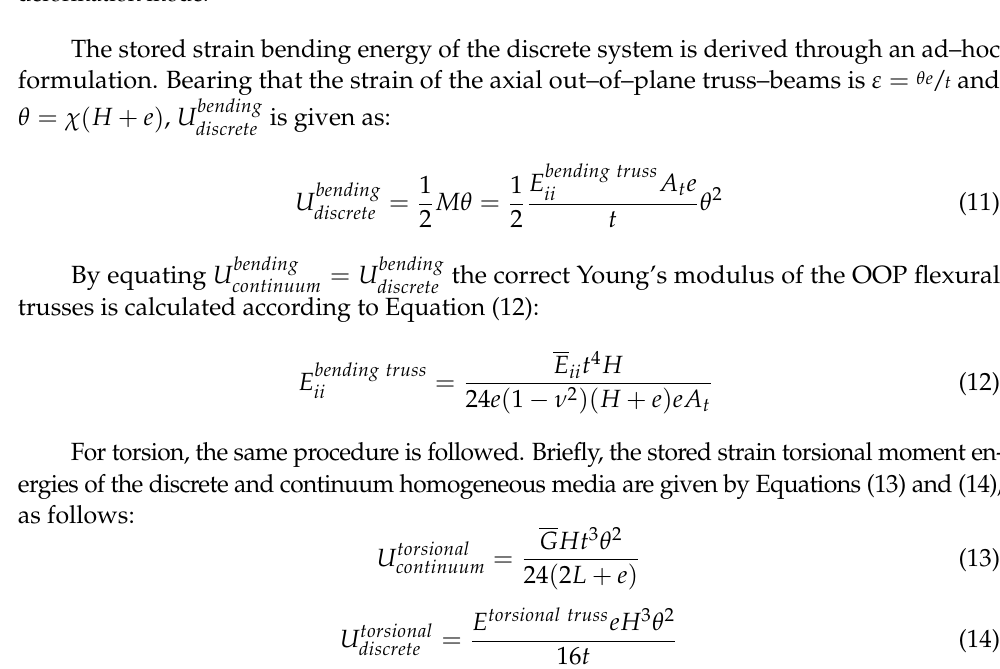
Figure 3. Out–of–plane unit cell: the tributary area for each truss and kinematics of each allowable deformation